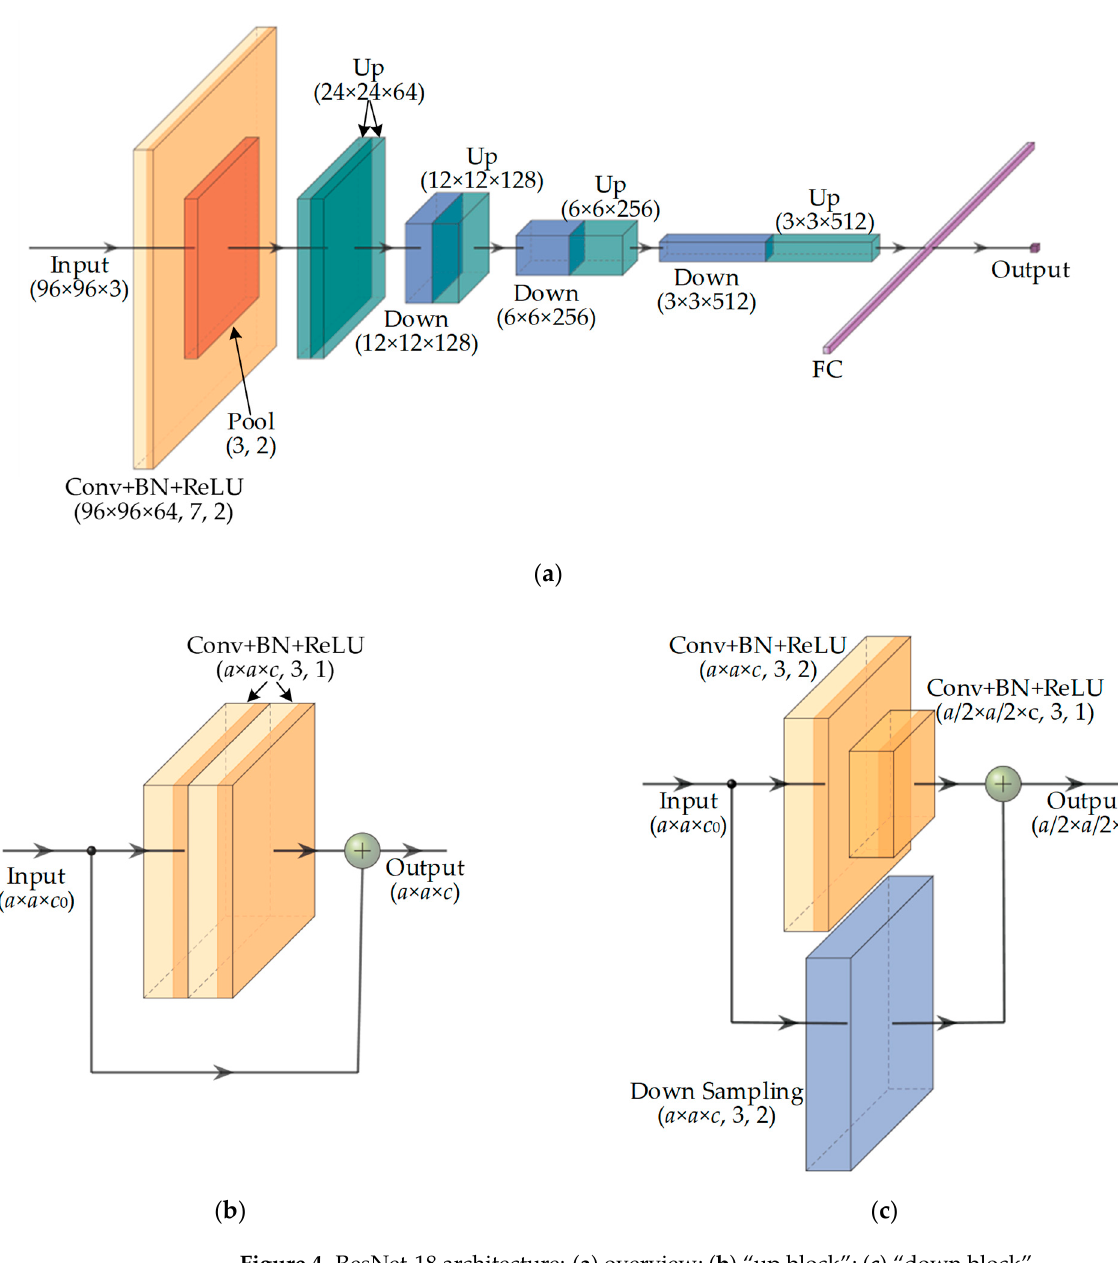
Figure 4. ResNet-18 architecture: ( a ) overview; ( b ) “up block”; ( c ) “down block”.